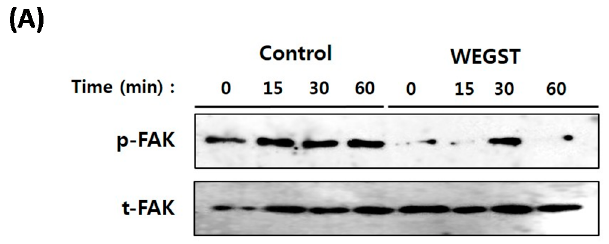
Figure 3. Cont. Figure 4.